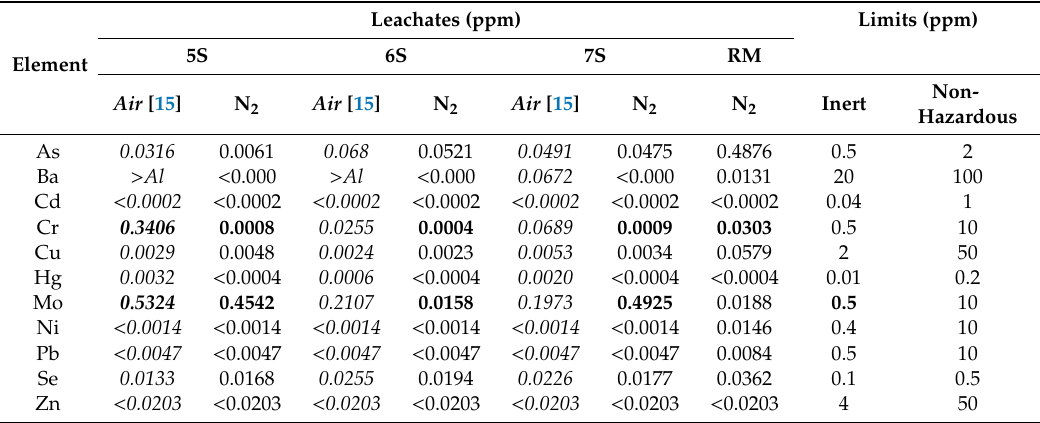
Table 3. Leachate Chemical Analysis of Selected Samples Fired at 800 ◦ C. Bold: highlighted pollutants; Italic: reference data for previously developed samples fired in